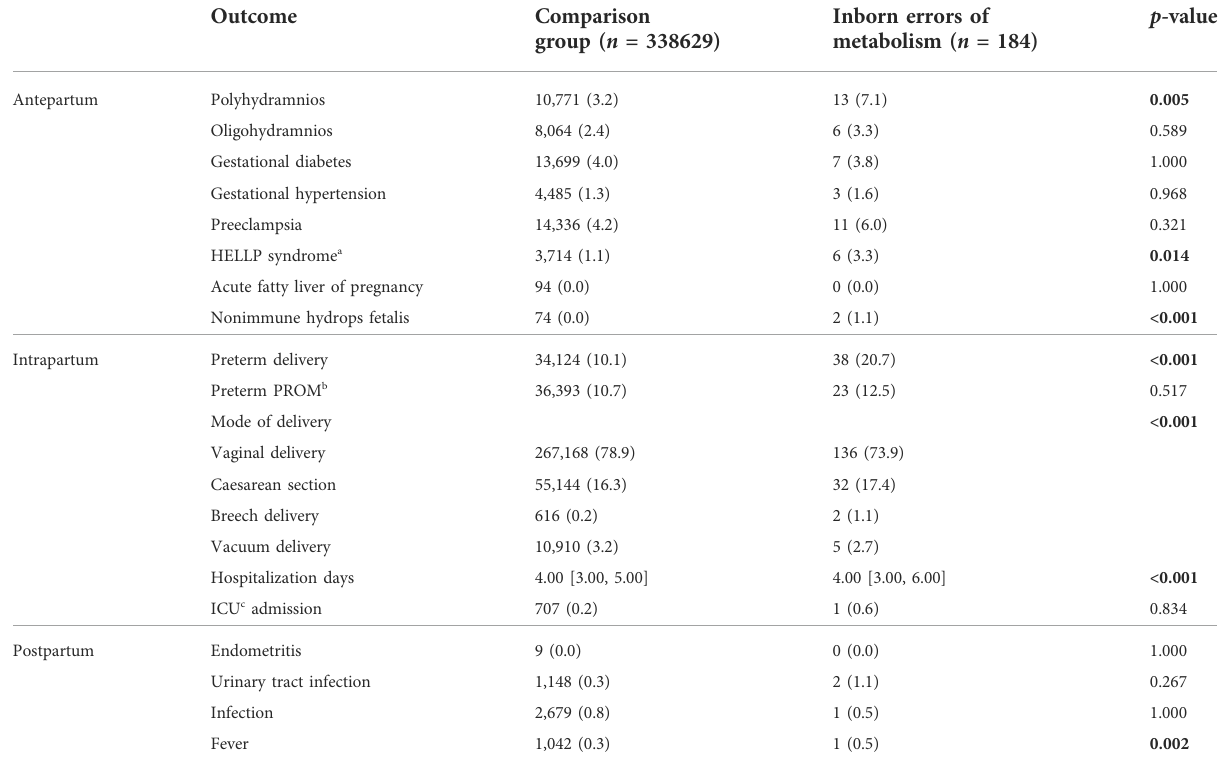
TABLE 2 Pregnancy